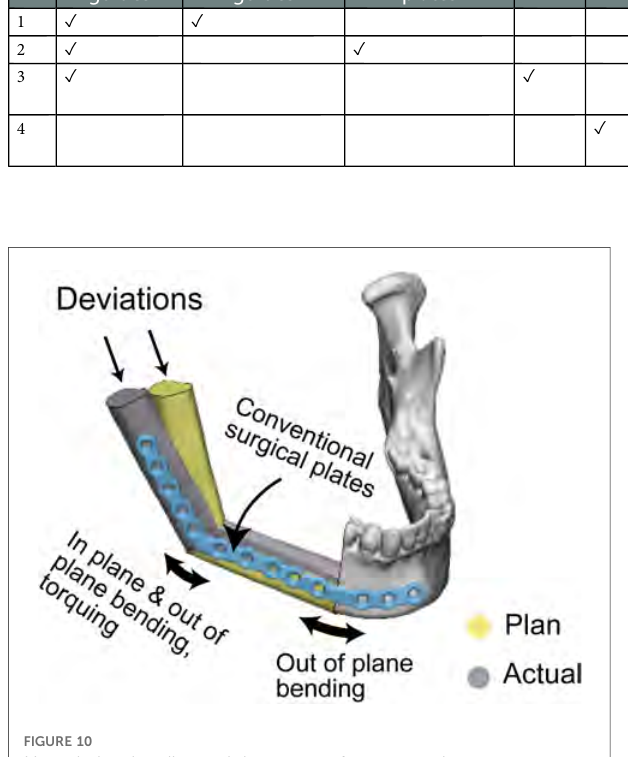
FIGURE 10 Manual plate bending and the source of reconstruction